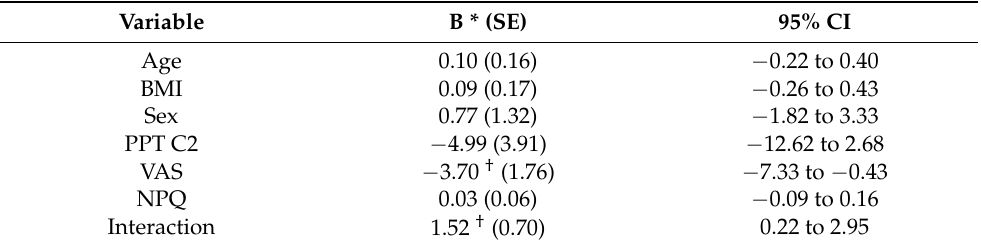
Table 3. Single moderation multiple regression analysis for the prediction of the cranio-cervical angle with the pressure pain threshold measured at C2 as the focal